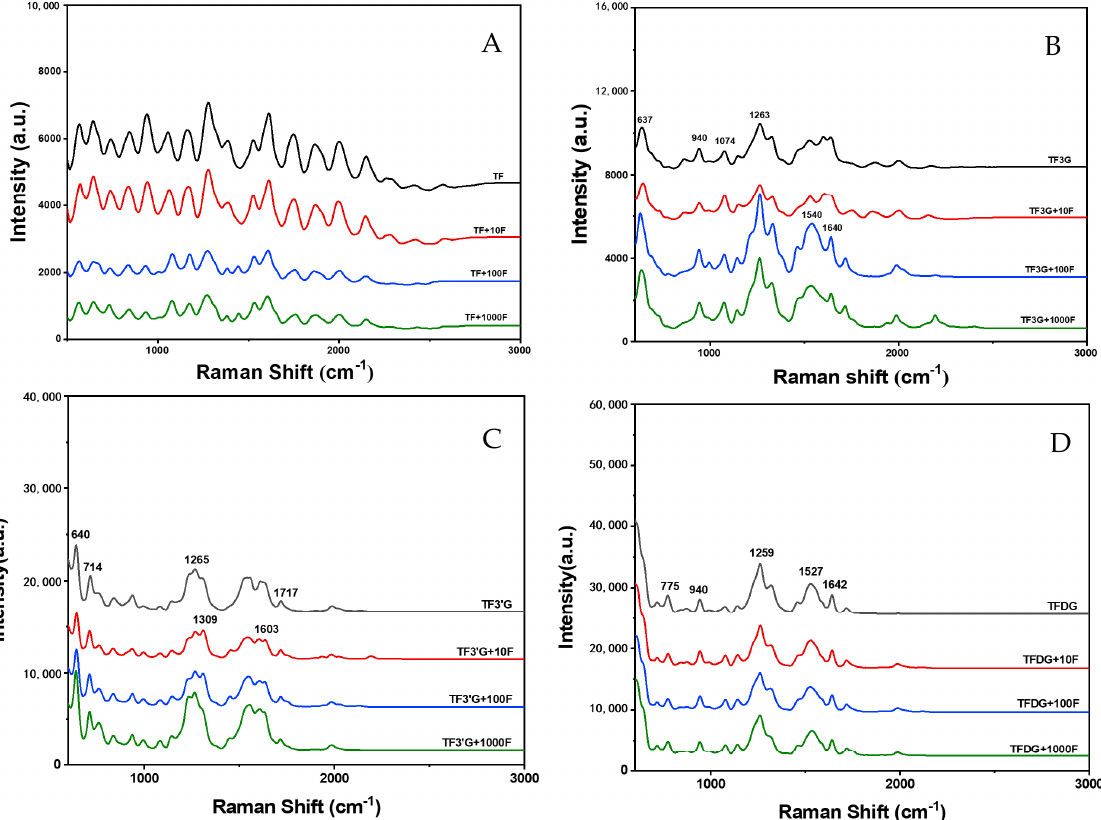
Figure 6. Raman spectra of TFs + different concentrations of F − : ( A ) TF treatment group, ( B ) TF3G treatment group, ( C ) TF3 ′ G treatment group, and ( D ) TFDG treatment group.